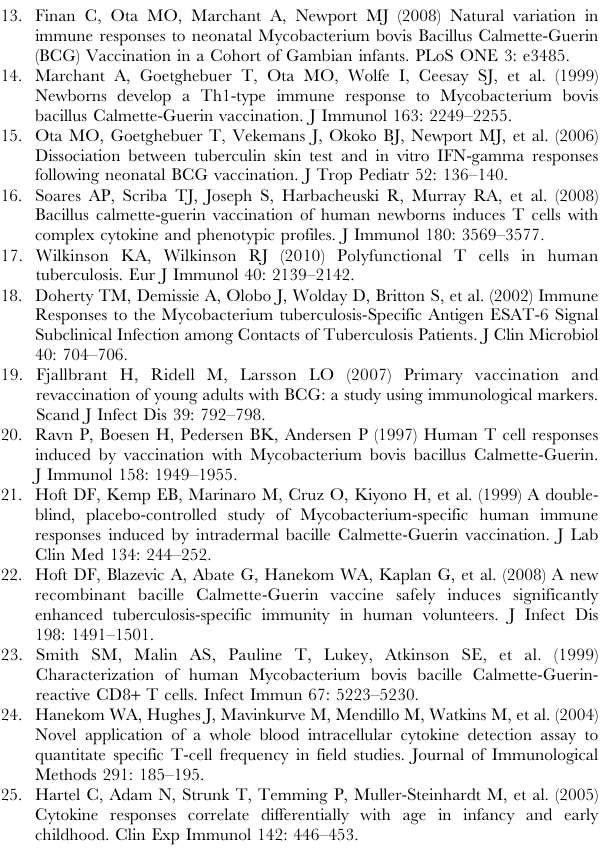
Figure S1 Concentrations of cytokines and chemokines in supernatants from children before (grey) and 10